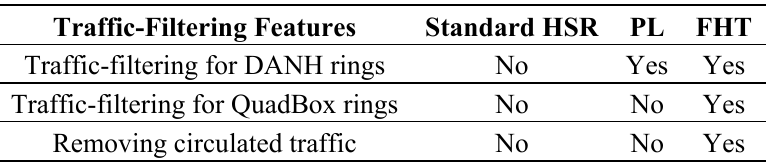
Table 3. Summary of traffic-filtering